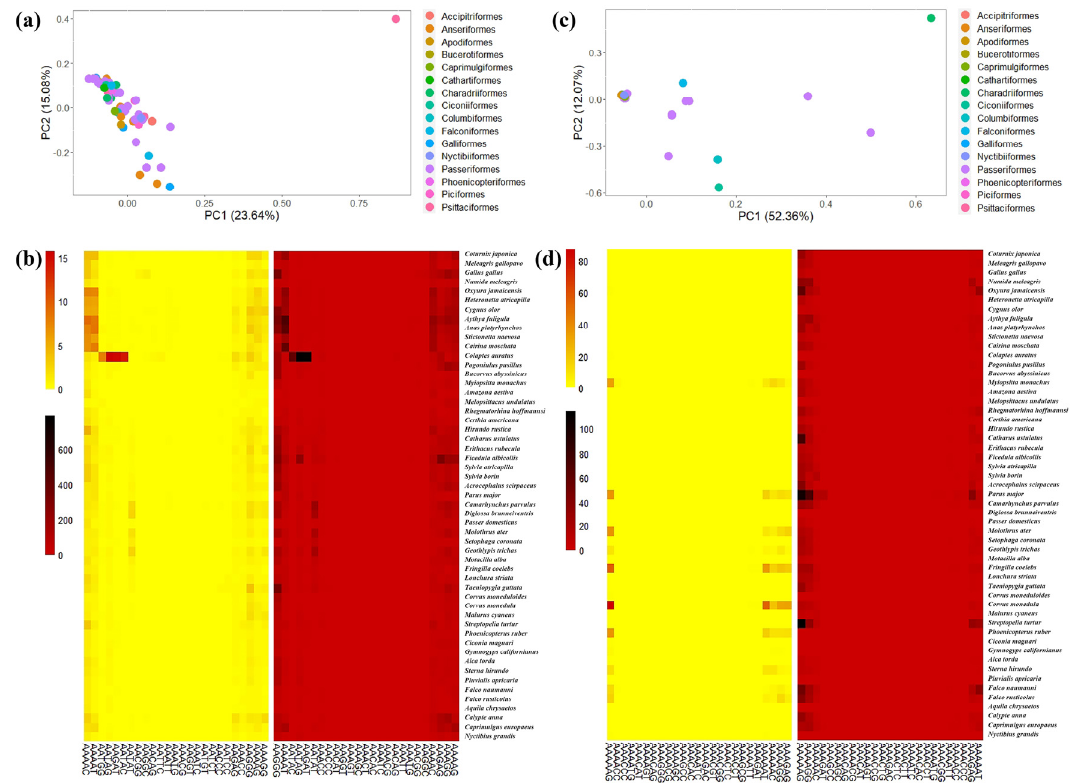
Figure 5. Phylogenetic PCA, loci/Mb heatmaps and bp/Mb heatmaps for penta- ( a , b ) and hexanucleotide ( c , d ) P-SSR motifs.